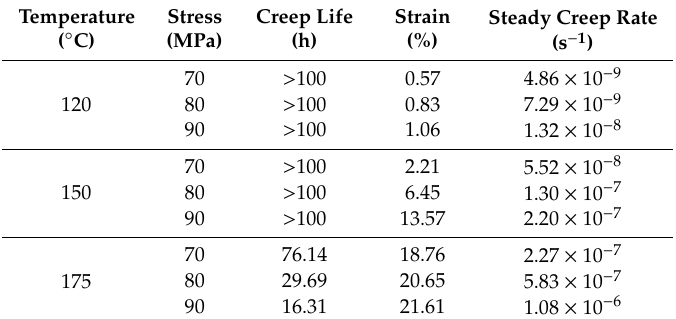
Table 3. Creep data of T5 specimens tested at 120–175 ◦ C and under 70–90